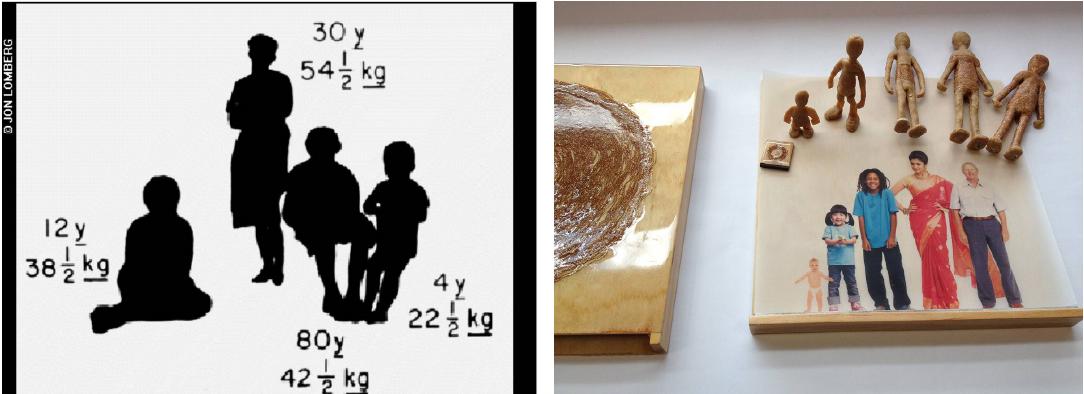
Figure 9. Shows a student redesign ( righ t) of one of the NASA Golden Record messages about ( left ) human growth. The redesign features proportionally weighted and scaled human figures rather than numerical symbols. The proportions are based on the record itself—something the students understood could be used by the aliens as a reliable measure of